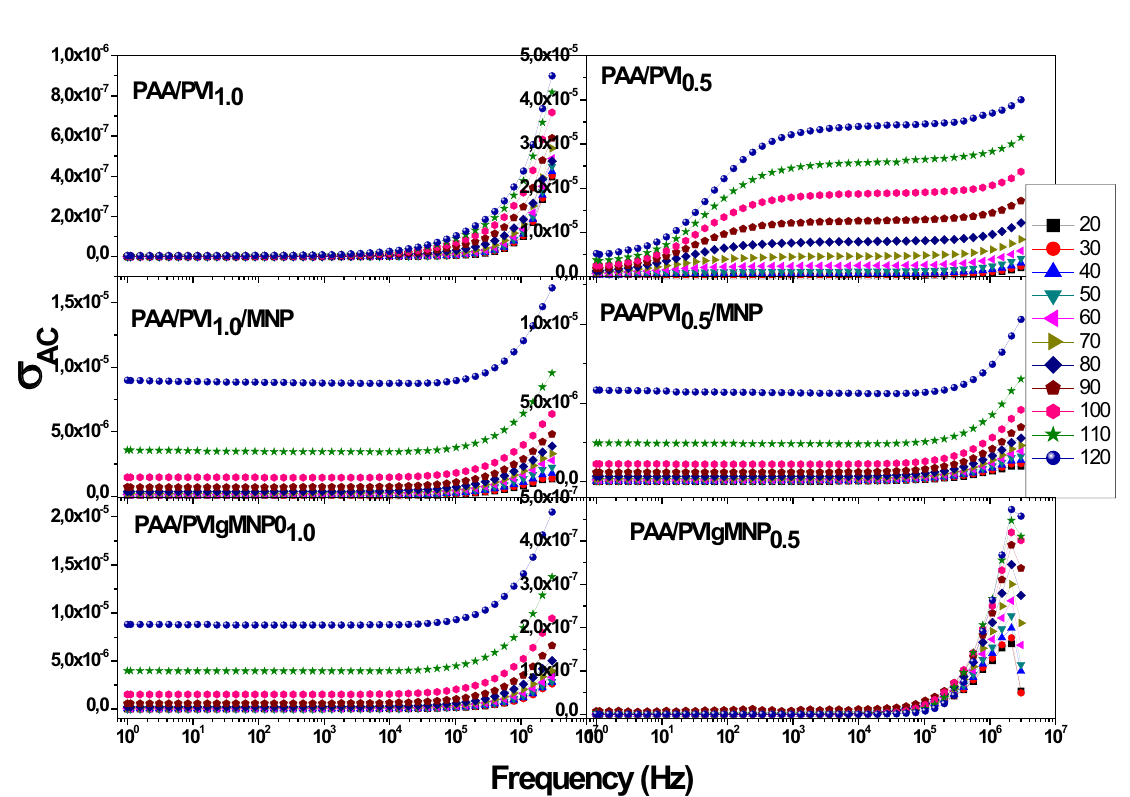
as a function of frequency at various temperatures. .